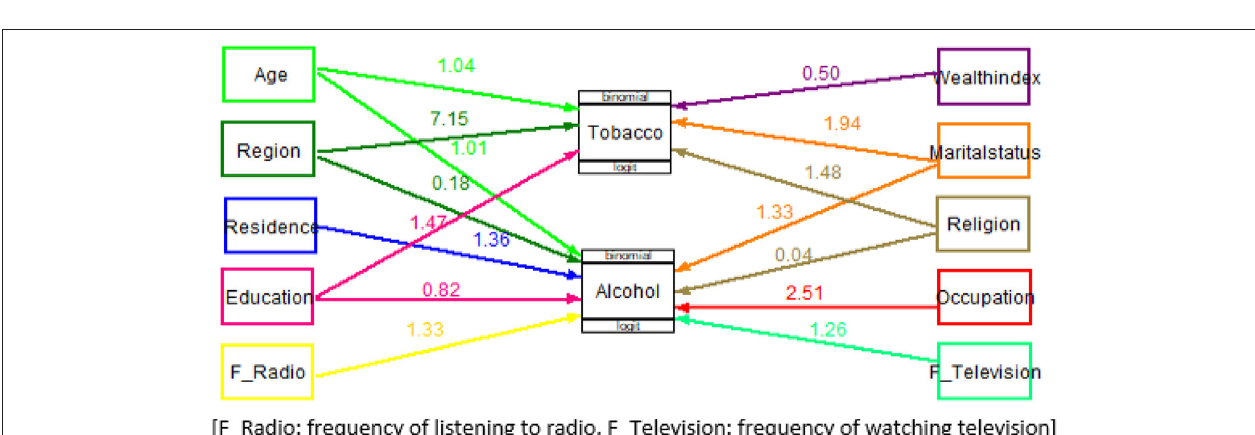
FIGURE 5 | GSEM for associated factors of risky health behavior among adult males in Ethiopia,